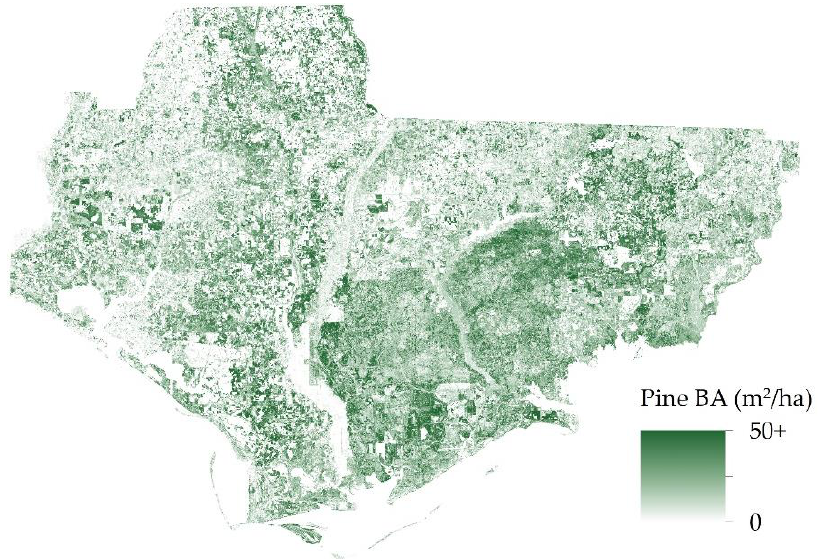
Figure 2. Pine basal area raster for the study area developed following the methods detailed in